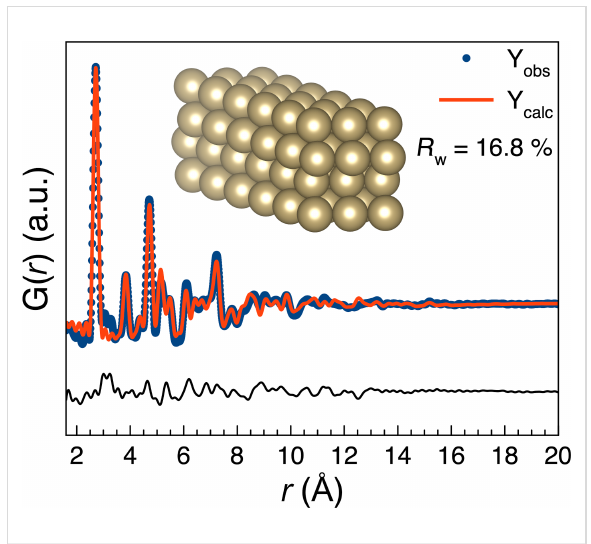
Figure 3: Fit of a hcp cluster (seen in the insert) to the PDF obtained from the Os NPs formed in methanol/water from OsCl 3 .